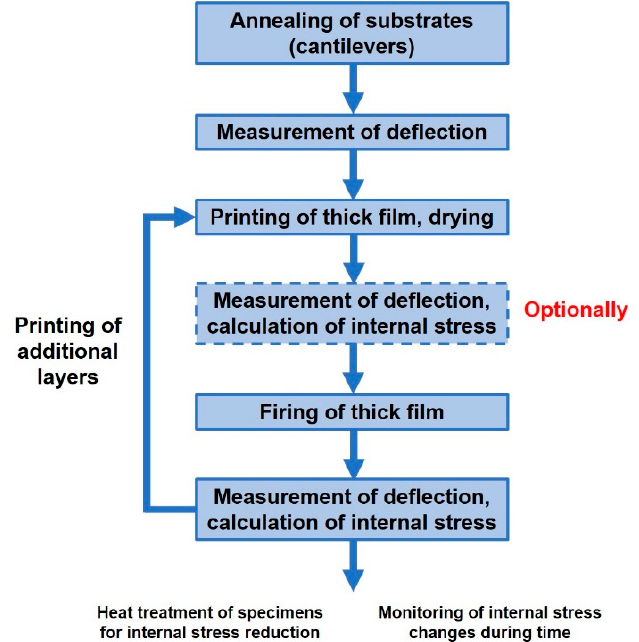
Figure 1. Procedure for the measurement of internal stress in thick films.